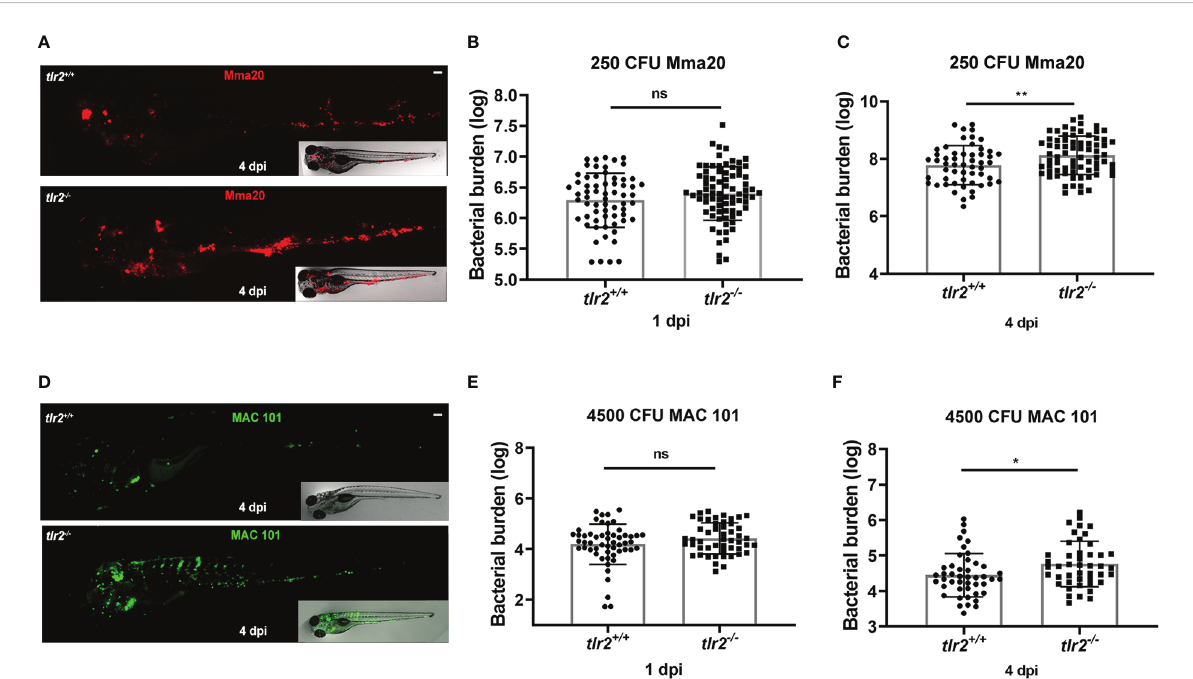
FIGURE 2 Quanti fi cation of bacterial burden in tlr2 zebra fi sh larvae with M. marinum or M. avium infection. Tlr2 +/+ and tlr2 − / − embryos were infected at 28 hpf by caudal vein infection with mCherry-labeled M. marinum strain Mma20 at a dose of ~ 250 CFU, or infected with ~ 4500 CFU wasabi- labeled M. avium strain MAC 101. (A) Representative images of tlr2 +/+ and tlr2 − / − embryos infected with mCherry-labeled M. marinum strain Mma20 at 4 dpi. (B, C) Quanti fi cation of bacterial burden of tlr2 +/+ and tlr2 − / − upon Mma20 infection at 1 dpi and 4 dpi. (D) Representative images of tlr2 +/+ and tlr2 − / − embryos infected with wasabi-labeled M. avium strain MAC 101 at 4 dpi. (E, F) The bacterial burden of tlr2 +/+ and tlr2 − / − upon MAC 101 infection were quanti fi ed at 1 dpi and 4 dpi. In (B, C, and E, F) data (mean ± SD) were combined from three independent experiments. Statistical signi fi cance of differences was determined by unpaired t-test for comparison between the tlr2 mutant and wild type group. ns, non-signi fi cant; * P < 0.05, ** P < 0.01. Scale bar: 50 µm. Sample size (n): 64, 78 (B) , 54, 72 (C) , 54, 50 (E) , and 45, 45 (F)